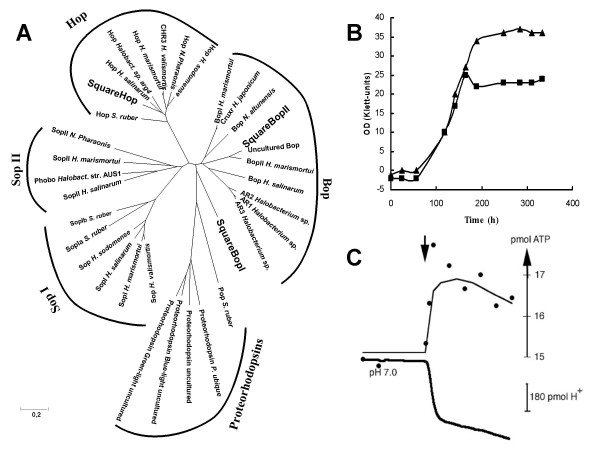
Phototrophic growth in H. walsbyi. (A) Protein phylogenetic tree showing the position of the "opsin"-homologs encoded by H. walsbyi, indicated as SquareBopI & II and SquareHop for the proton pumping bacteriorhodopsins and chloride pumping halorhodopsin respectively. Trees were constructed with the neighbor-joining method using 1000 bootstrap replicates. Bop, bacteriorhodopsins; Hop, halorhodopsins; SopI & II; sensory-rhodopsins. (B) Phototrophic growth of aerobic (▲) and anaerobic (■) cultures of H. walsbyi incubated in the light. (C) Photo-phosphorylation in H. walsbyi measured through light induced ATP generation (upper curve) and proton (H+) extrusion (lower curve). Phylogenetic analysis was performed using the Microbial Genome Analysis System package MiGenAS [38,39].